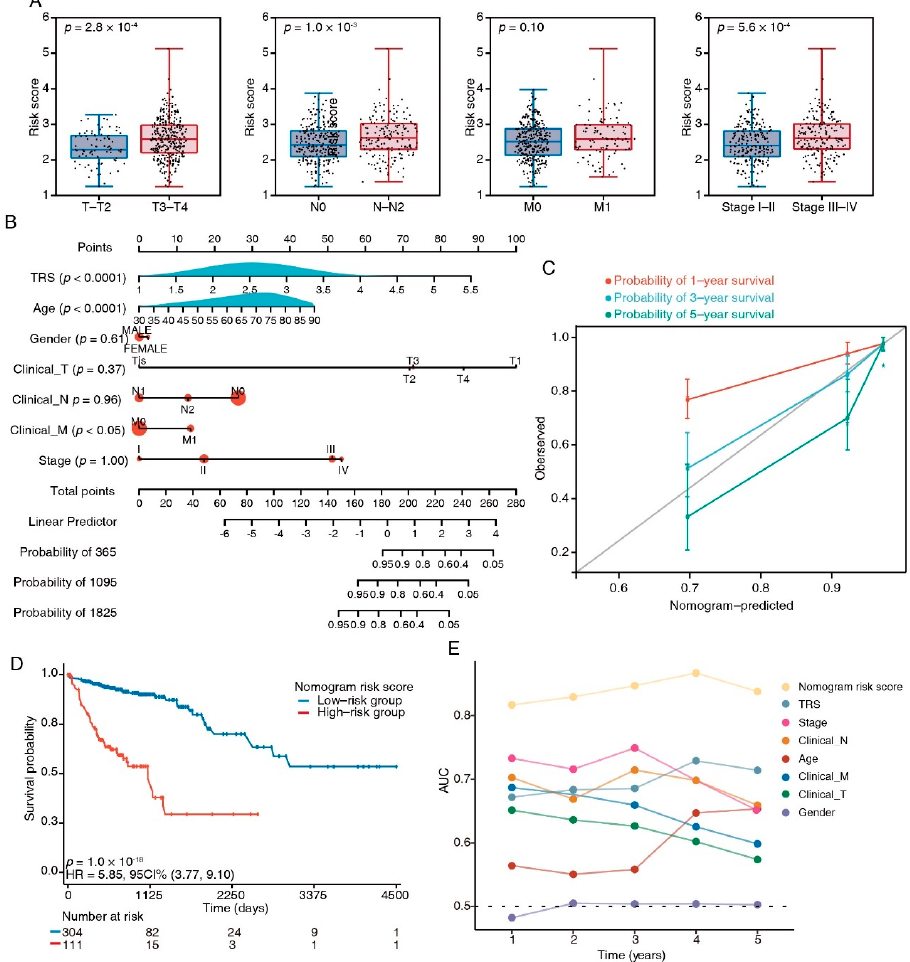
Figure 6. Nomograms showing the results of prognostic models using the TFEB signature and TNM staging system to predict OS of patients with CRC. ( A ) Distribution of TRS in clinicopathological variables, e.g., tumor (T), lymph node status (N), metastasis (M), and clinical stage. ( B ) Nomogram based on risk score and clinical factors. ( C ) Calibration plots of the nomogram for predicting the probability of 1-, 3-, and 5-year survival, • represents the mean and * represents the media. ( D ) Kaplan–Meier curves of OS between high-risk and low-risk patients in the TCGA-COAD cohort. ( E ) tROC analysis to assess the accuracy of the